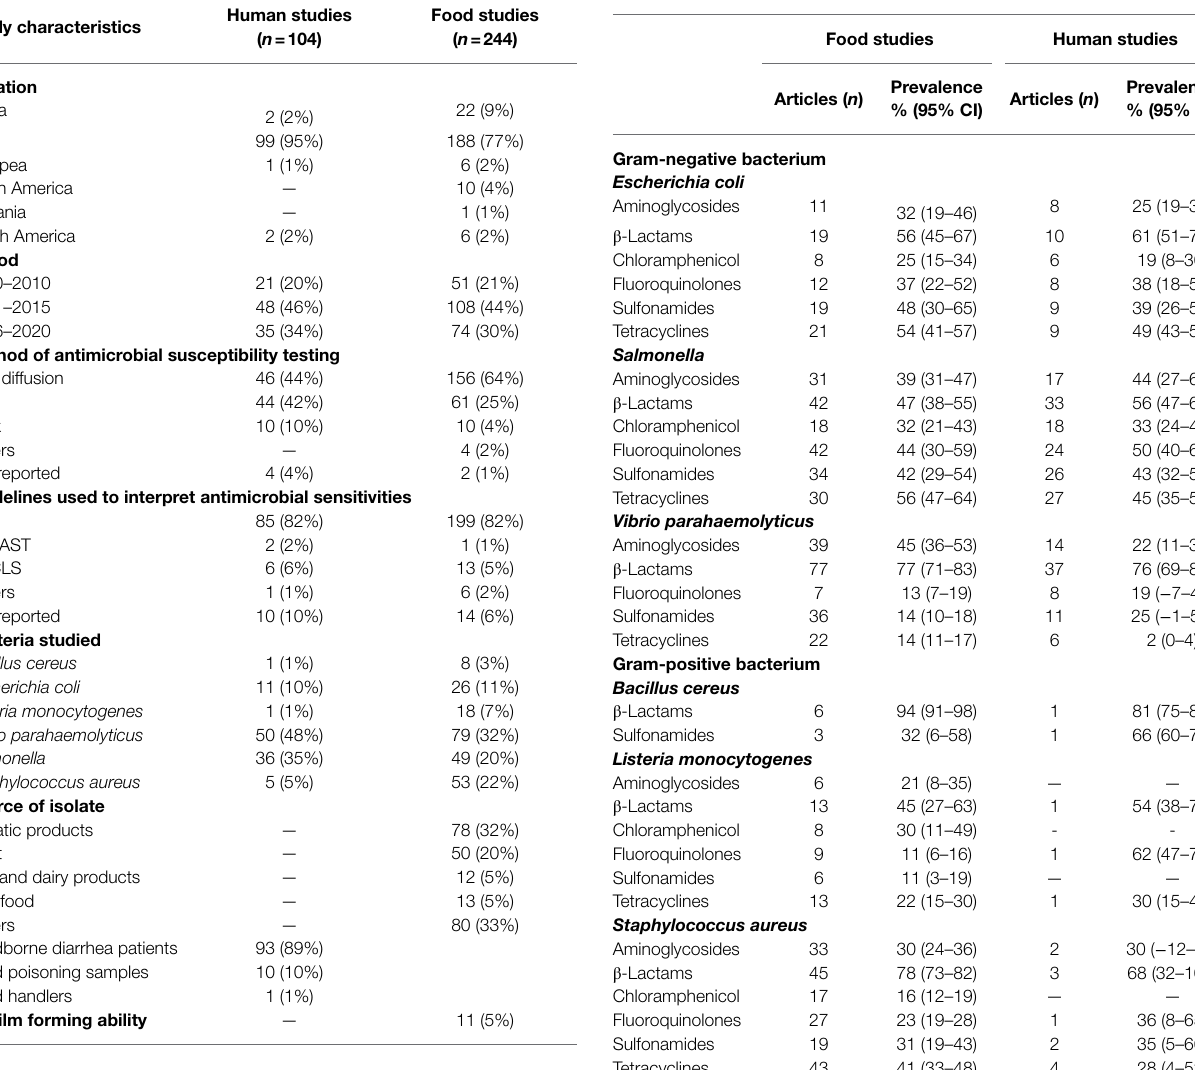
TABLE 1 | Included studies characteristics. TABLE 2 | Pooled prevalence of antibiotic resistance from meta-analysis of food studies and human studies, by antibiotic